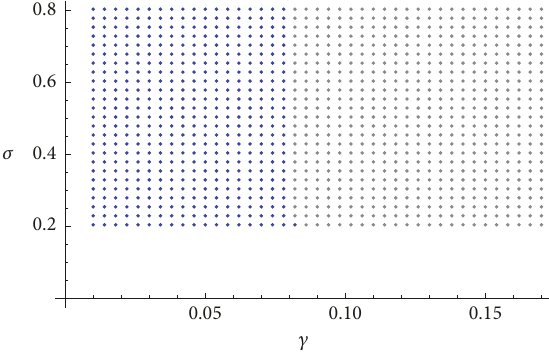
Figure 4: Bifurcation portrait as regards the supercritical Hopf bifurcation for 𝑟 = 10 −4 , 𝛼 = 10 −4 , 𝜀 = 10 −3 , 𝑚 = 0.5 , and 𝑠 = 1.2 . Negative sign (blue region) of the first Lyapunov coefficient at the critical surface 𝛽 cr = 𝛽 cr (𝛾, 𝜎) , in the parameter plane (𝛾,𝜎) (no 𝛽 cr in the gray region).